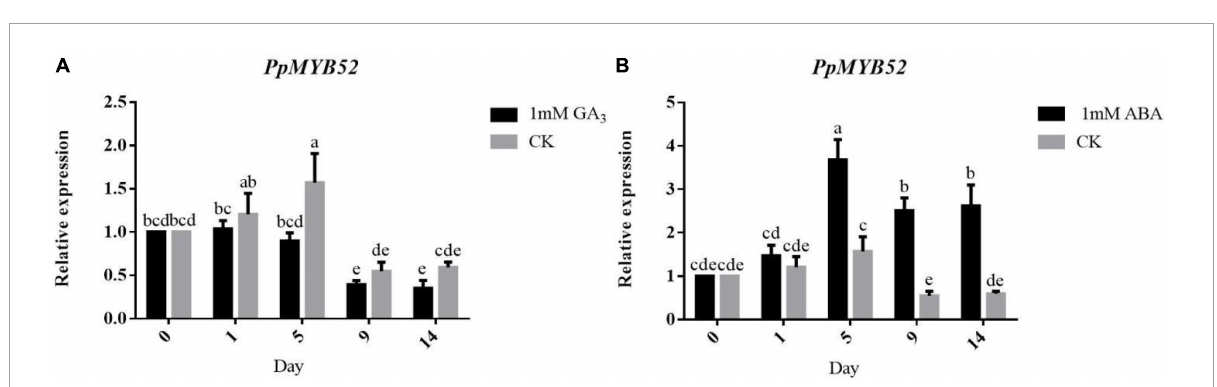
FIGURE3 Expression of PpMYB52 in the flower buds of Zhongyou 4 under GA 3 and ABA pretreatments. (A) Expression of PpMYB52 in the flower buds of Zhongyou 4 under 1 mM GA 3 + 0.5% Triton 100 treatment. (B) Expression of PpMYB52 in the flower buds of Zhongyou 4 under 1 mM ABA + 0.5% Triton 100 treatment. Deionized water + 0.5% Triton 100 was used as a blank control (CK). The values represent the means ± SD of three replicates, and the different letters above the bars represent significant differences; P <